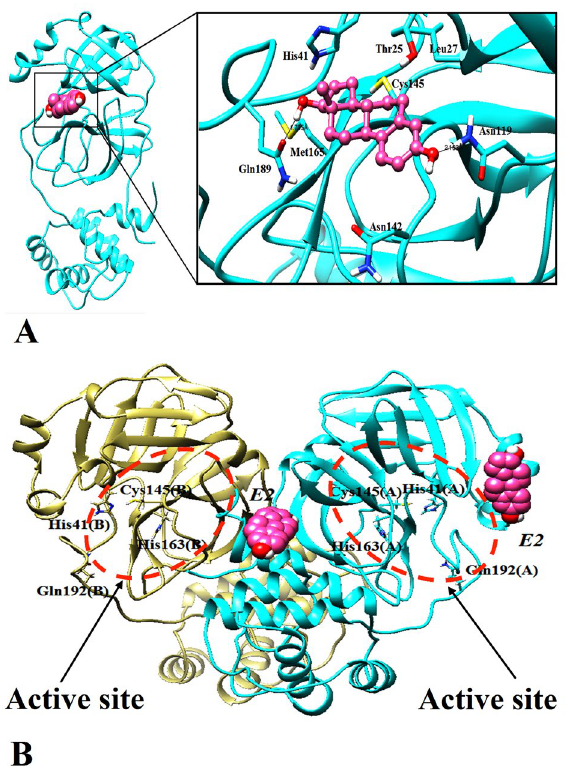
Figure 2. The binding modes of E2 with protease active site. ( A ) The final step of MD simulation of E2 with protease in monomeric state after MD simulation. ( B ) The final step of MD simulation of E2 with homo- dimeric. Formation of hydrogen bonds between E2 and protease residues is shown by black line. Identical residues interacted with E2 depicted by stick form. Protease colored by cyan; ligands indicated by sphere, ball and stick form; E2 is in